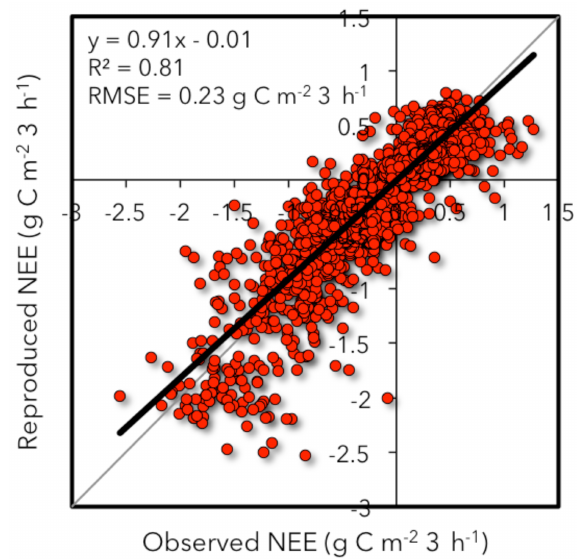
Figure 4. Observed versus reproduced net ecosystem exchange (NEE) at the 3-hourly time step for a single year at the Tonzi Ranch AmeriFlux/FLUXNET site (Baldocchi and Ma, 2013).